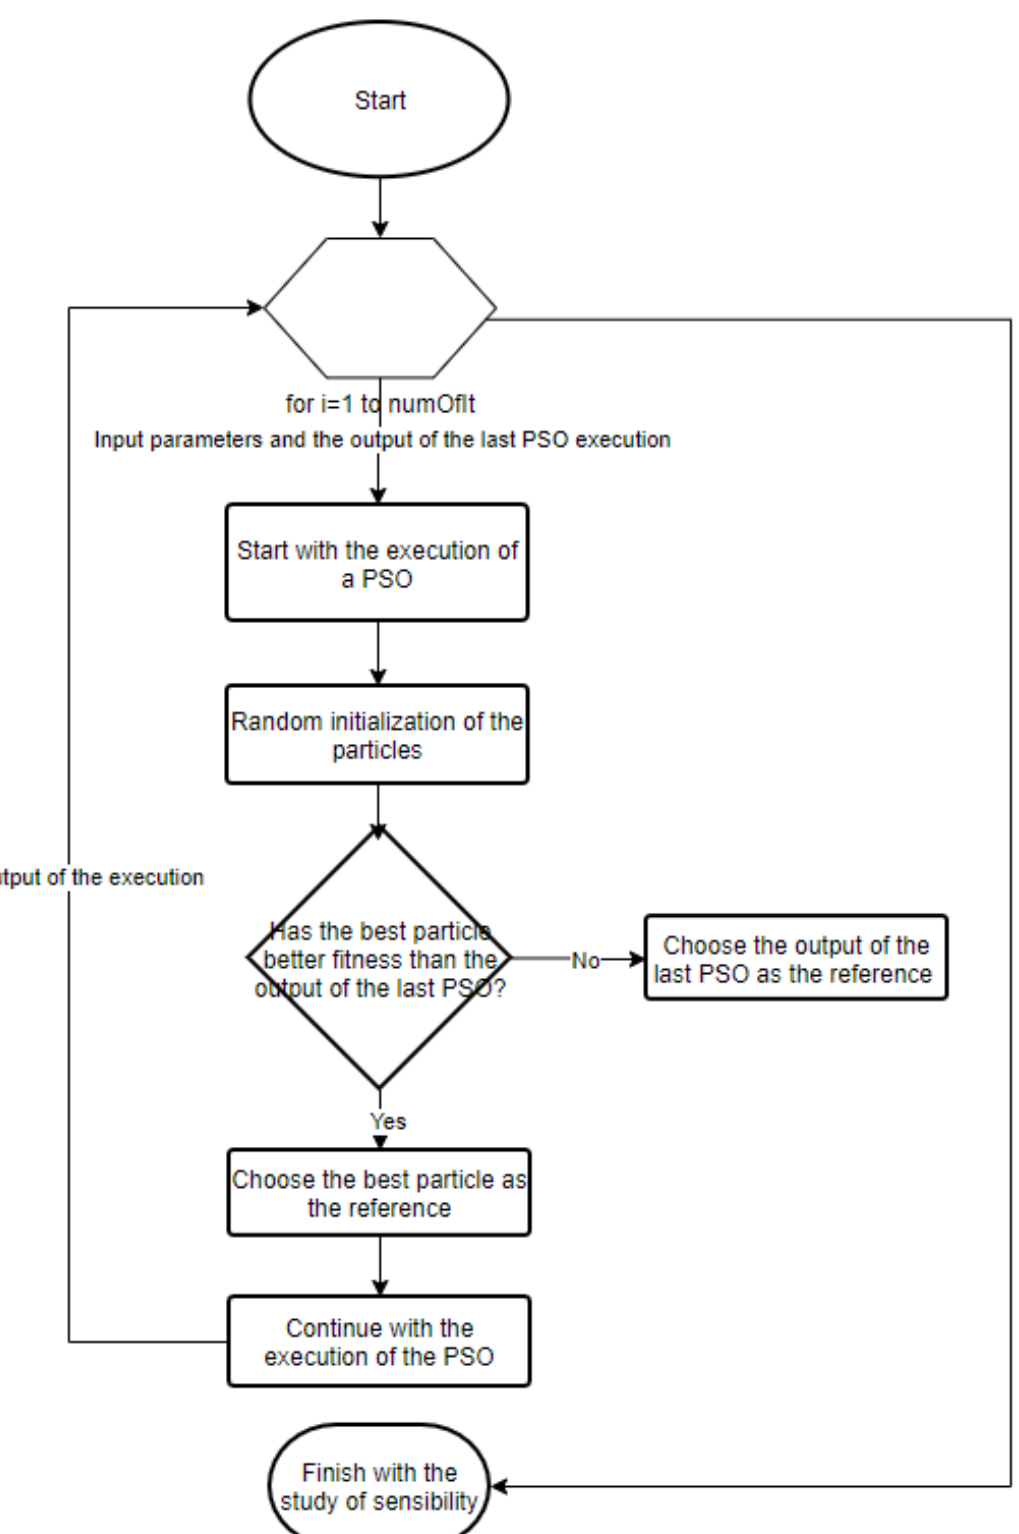
Figure 6. Flux diagram of the developed PSO algorithm.